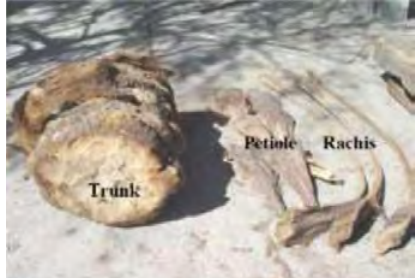
Figure 1. Dried Date Palm Main Parts (Mahdavi, 2010)